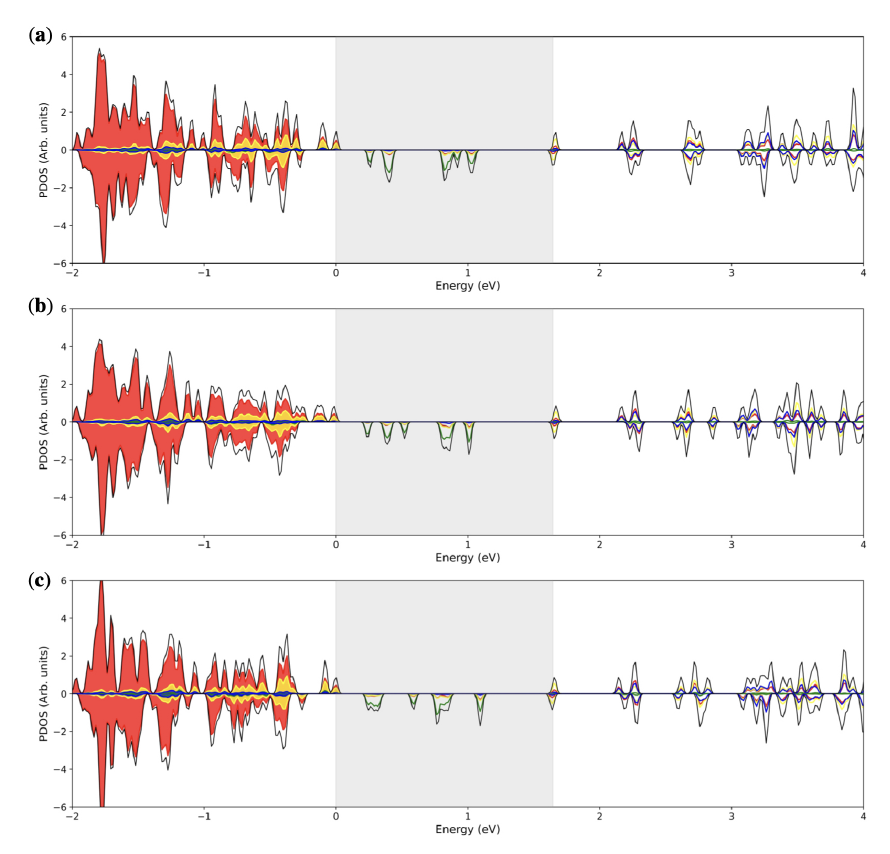
Figure 4. PDOS for configurations ( a ) α 2.1 , ( b ) α 2.2 and ( c ) α 2.3 (copper = red, sulfur = yellow, alu- minium = blue and iron =